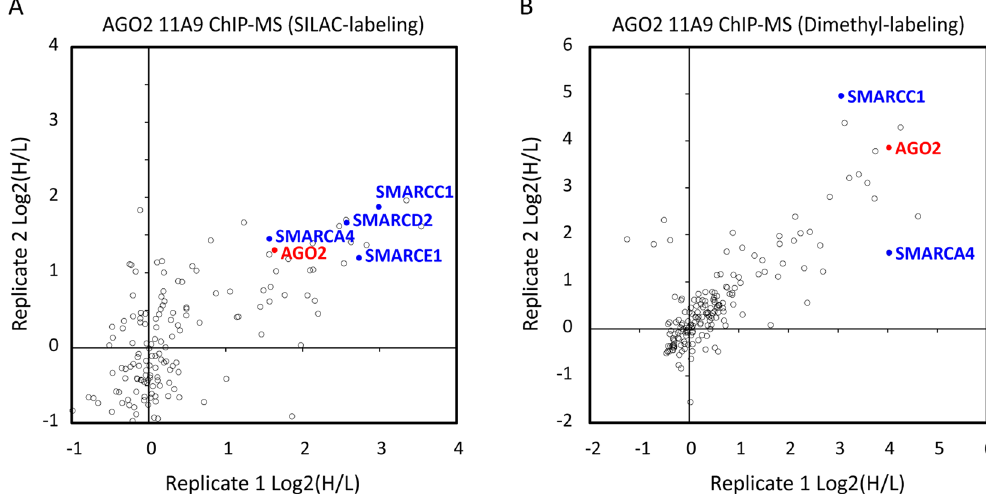
Figure 1. Anti-AGO2 ChIP-MS in epidermal stem cells suggests AGO2 interaction with SWI/SNF complex proteins. ( A ) ChIP-MS with SILAC labeling of AGO2 11A9 antibody and anti-FLAG control. ( B ) ChIP-MS with dimethyl-labeling of AGO2 11A9 antibody and IgG isotype control. In red anti-AGO2 11A9 antigen AGO2 and in blue SWI/SNF complex